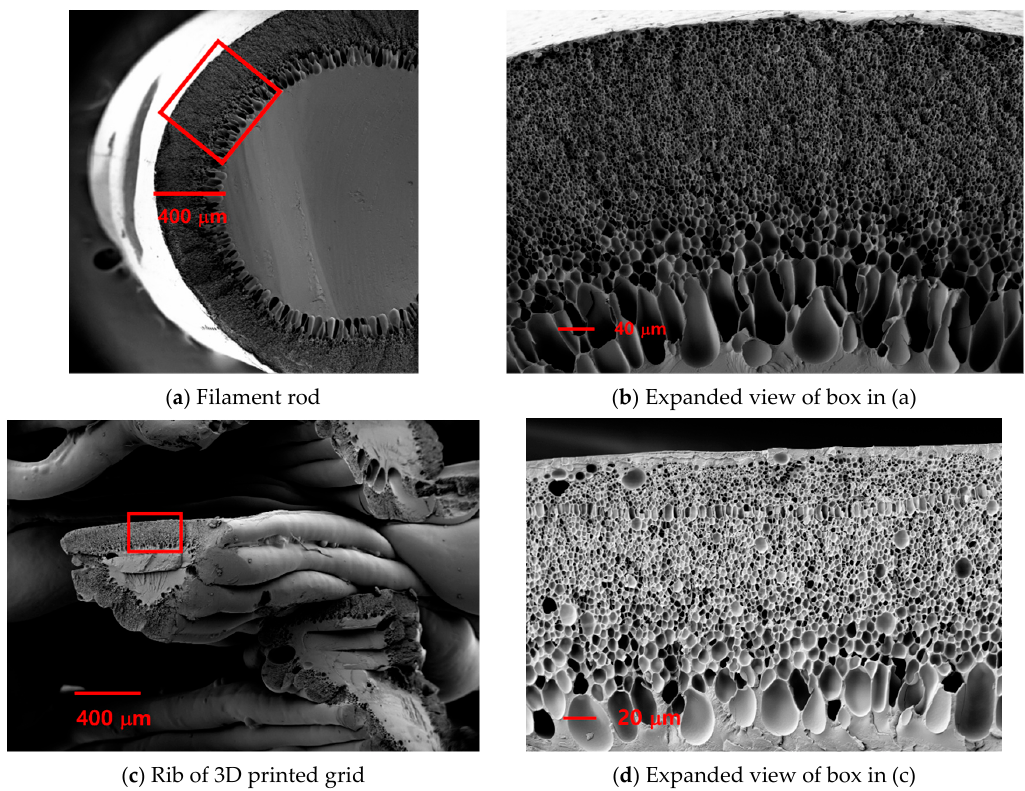
Figure 2. Comparison of SEM micrographs in the foamed copolymers. Results are for filament rod ( a ) and additively manufactured and post-foamed grid structure ( c ). ( b , d ) Expanded view of box in ( a ) and ( d ), respectively.